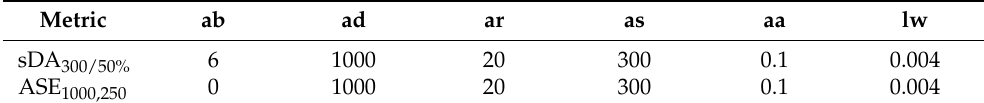
Table 1. Radiance simulation